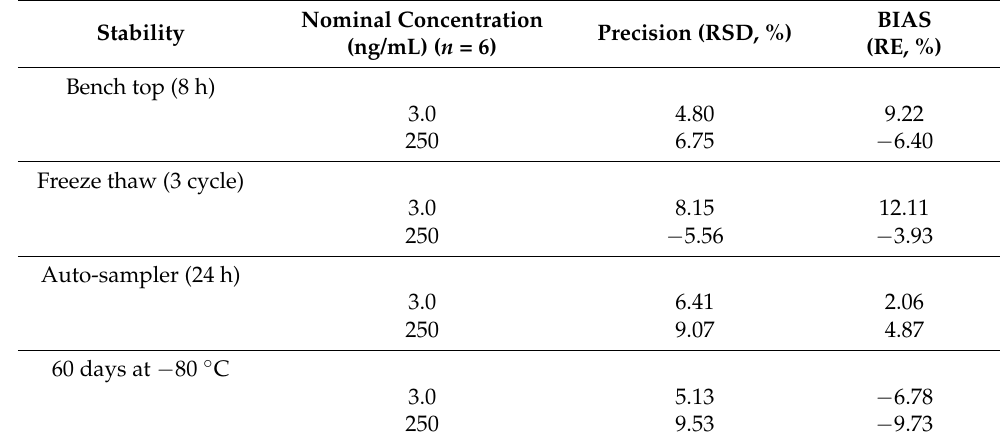
Table 5. Stability data of LEM in human plasma.